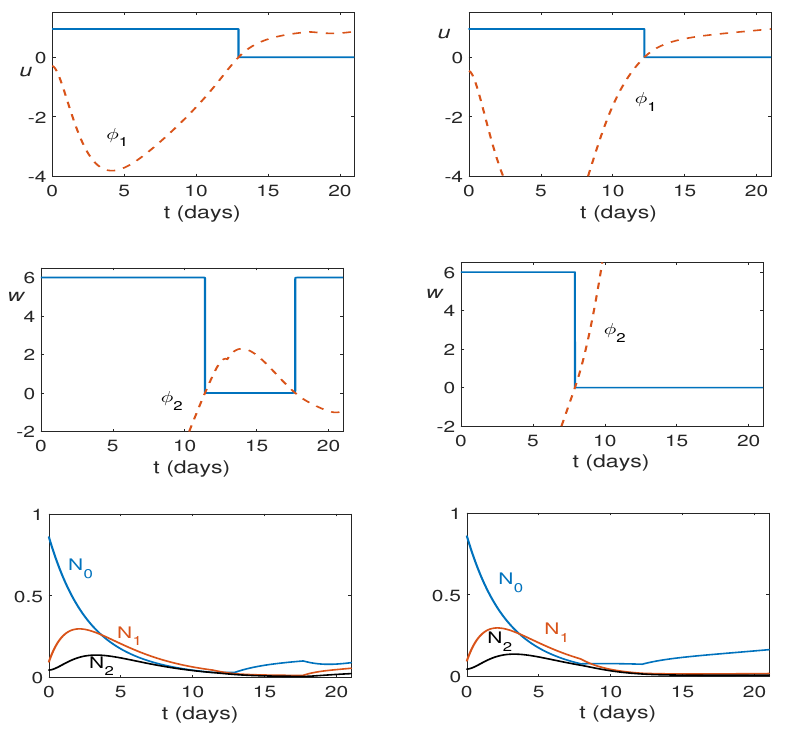
Fig. 4 Examples of locally optimal controls u (citotoxic agent, top), w (recruiting agent, middle) and their corresponding trajectories (bottom) for weights s 2 = 0 (left) and s 2 = 0 . 1 (right). The parameter values are given in Table 2.